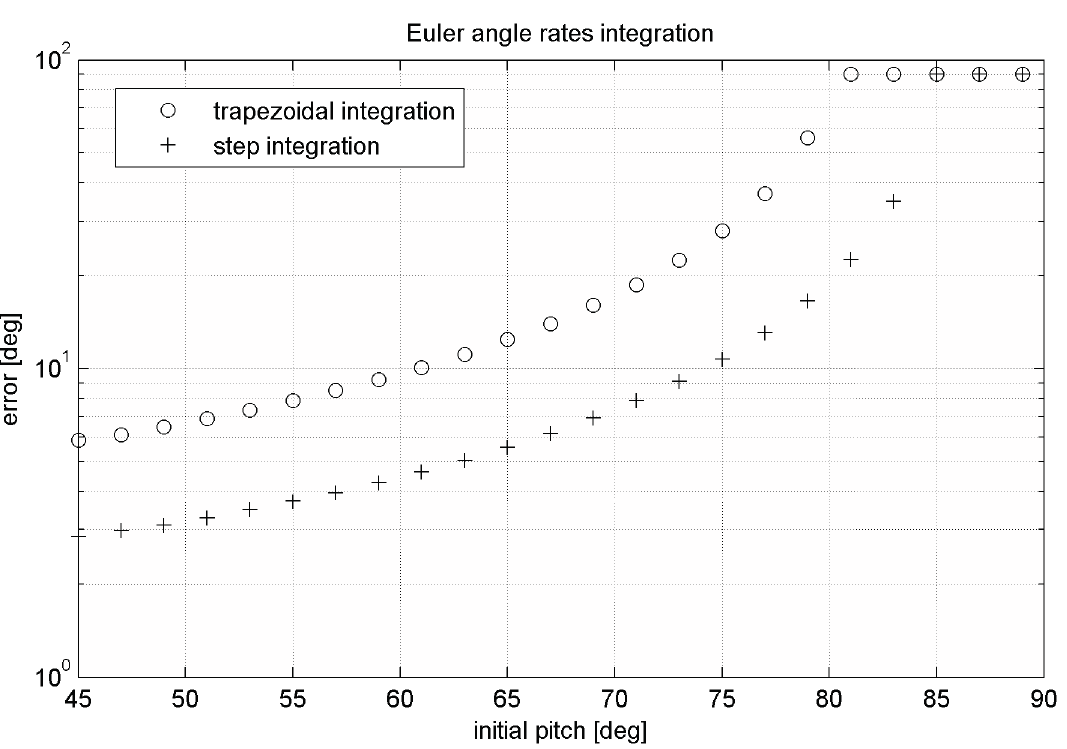
Figure 10. Relation between error and the initial pitch angle β 0 at f sample = 1000 Hz of the Euler angle rates-based